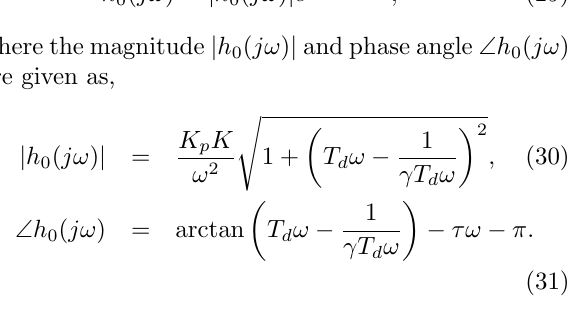
Figure 6: Bode plot of the proposed controller, i.e. Alg. 2.1 and Eq. (27), for a DIPTD plant with K = 1, τ = 1, fixed δ = 1 . 6 and ¯ c = 2 . 1, and varying γ from 1 to ∞ . γ = ∞ corresponds to a PD controller and 1 ≤ γ < ∞ to PID controllers. Notice that GM − 1 and GM − 1 are not translated to dB in this plot.